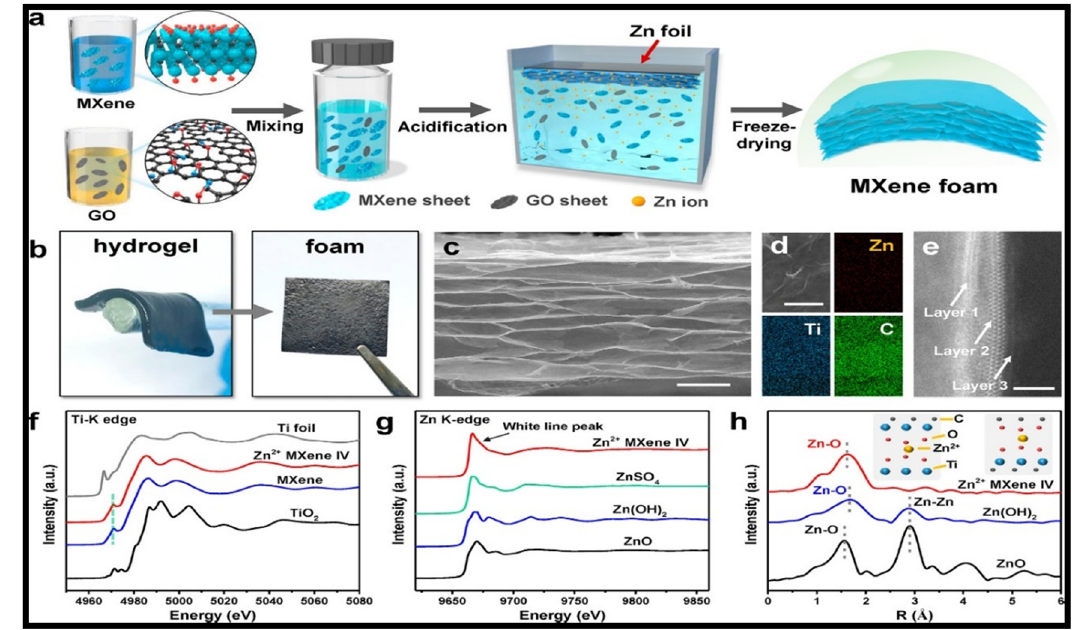
Figure 28: ( a ) Schematic representation of ion - di ff usion - induced gelation process, ( b ) free - standing and fl exible Zn 2 + MXene IV hydrogel and foam, ( c ) cross - sectional scanning electron microscopy, ( d ) energy - dispersive X - ray spectroscopic elemental mapping, ( e ) high - angle annular dark - fi eld scanning transmission electron microscopy images of the Zn 2 + MXene IV foam, ( f ) Ti K - edge X - ray absorption near - edge structure, ( g ) Zn K - edge, and ( h ) Fourier transform extended X - ray absorption fi ne - structure spectra of the Zn 2 + MXene IV foam and references. Scale bars: ( c ) 50 μ m, ( d ) 5 μ m, ( e ) 2 nm [ 183 ]